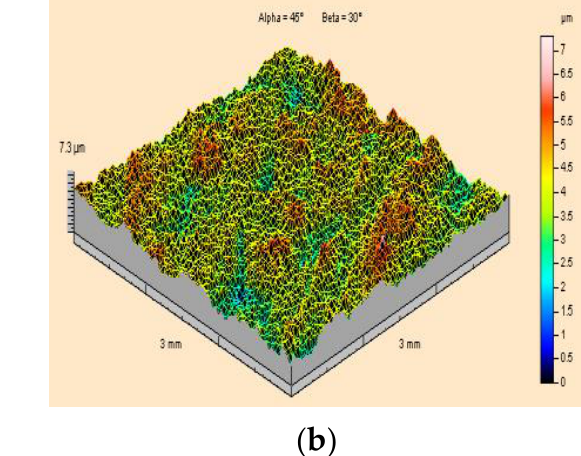
( b ) Figure 4. Surface topography of X5CrNi18-10 steel specimens prior to the application of paint coating and prior to ice-water jet treatment: ( a ) Grey scale map under scanning electron microscope (400×magnification); ( b ) Isometric image. After removal of the paint coating using a high-pressure water-ice jet, carried out with different treatment parameters (p w = 20 MPa and p w = 35 MPa), scanning electron microscope images of the surface were observed, an example of which is shown in Figure 5a. You can see the very fine grain structure with its characteristic dark borders. To a small extent, you can see the individual primer paint particles remaining at the grain boundaries. They are only discernible at 400× magnification. Comparing the crystalline structure of the surface of the specimen before (Figure 4a) and after treatment (Figure 5a), it was found that they are similar, no significant differences were found. Similar conclusions were drawn with regard to the measurement of ST parameters. Here, too, almost identical results to those recorded for unpainted specimens were found. The surface topography, consisting of hills and depressions, is also almost identical. Their occurrence is rather irregular and similar to the results of specimens that are not sub- jected to the water-ice jet. The maximum height of the surface roughness of the specimens